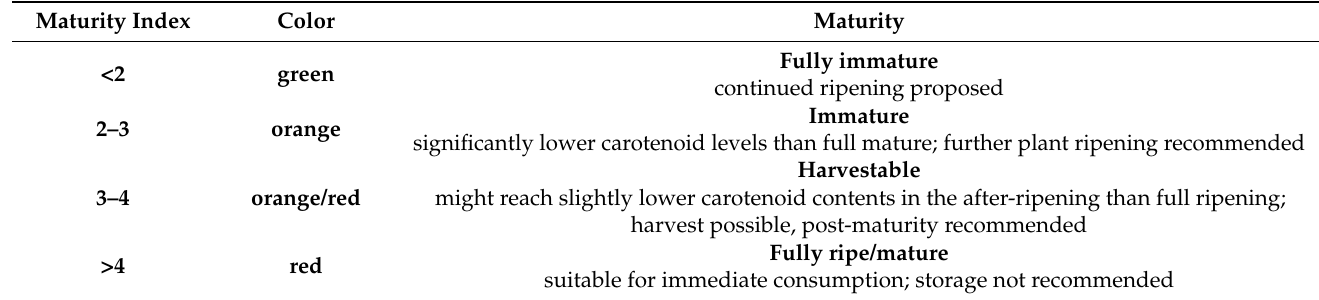
Table 3. Maturity index values, fruit colors and maturity levels for hot